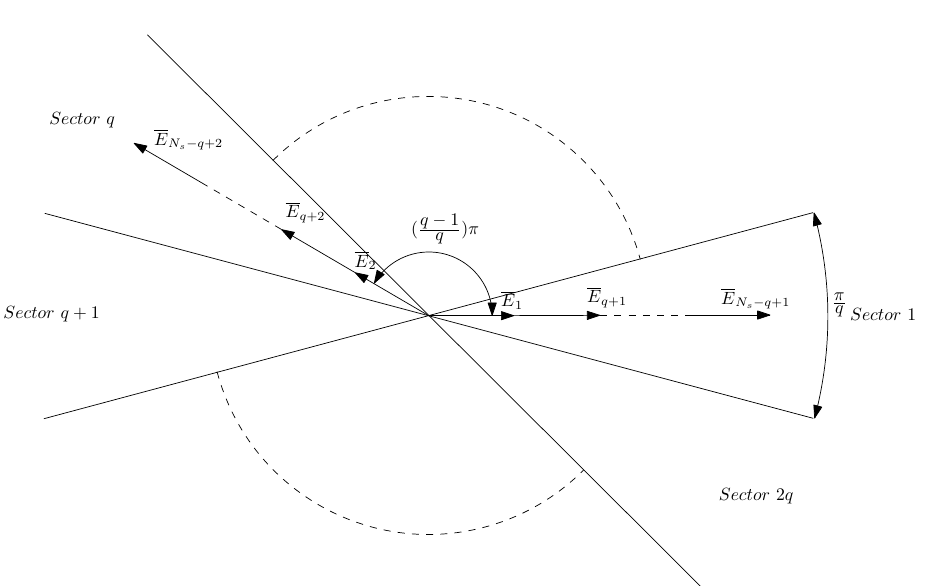
Figure 1. Star of slots of the fractional-slot permanent magnet (PM) synchronous machines (FSPMSMs) with an odd number of phases arranged in double-layer slots in the case where the phasors of the back-EMFs induced in the coils of a given phase are colinearly aligned in one sector among the two assigned to the phase.